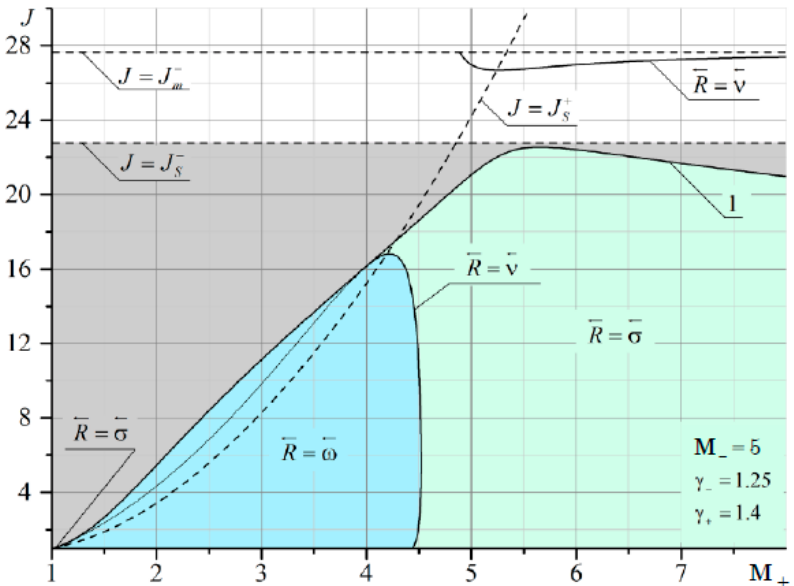
Figure A3. Domains of existence of reflected discontinuities for refraction from a gas consisting of combustion products into a diatomic gas. The Mach number of the flow from which the shock comes is M – = 5. The domains of existence of reflected discontinuities for refraction from a gas consisting of combustion products into a monatomic gas at the Mach number of the flow M – = 2 are shown in Figure